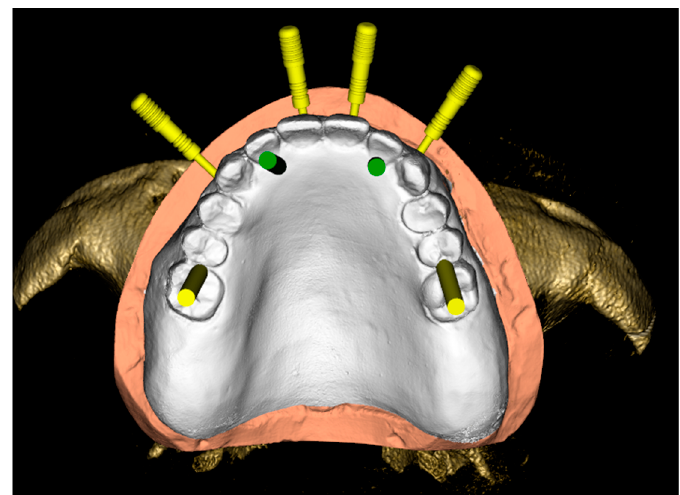
Figure 5. Virtual positioning of the implants, based on the aesthetic prosthetic project.